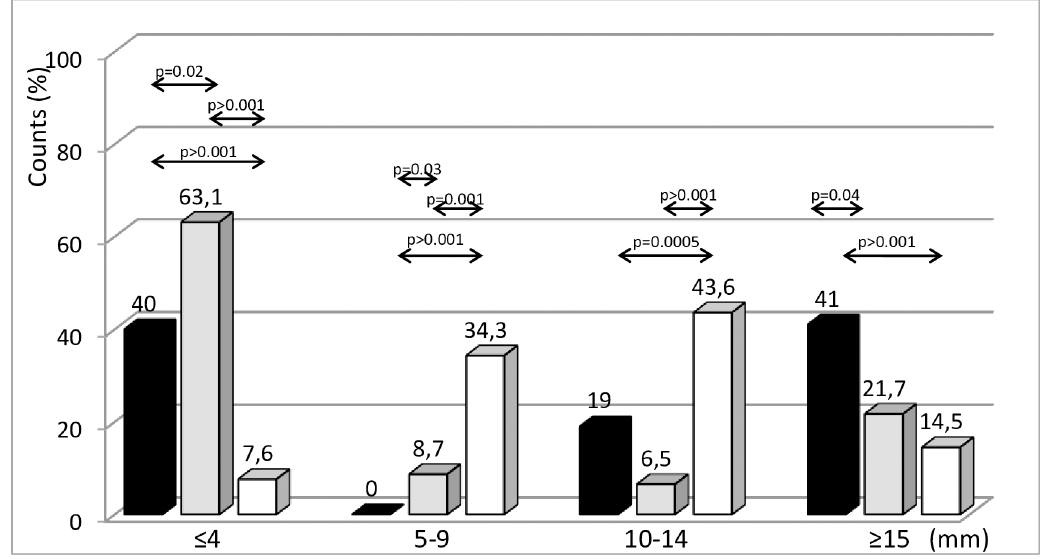
Fig 2. Distribution of TST sizes among the study groups: TB patients (black bars), non-TB patients (grey bars) and young healthy volunteers (white bars).